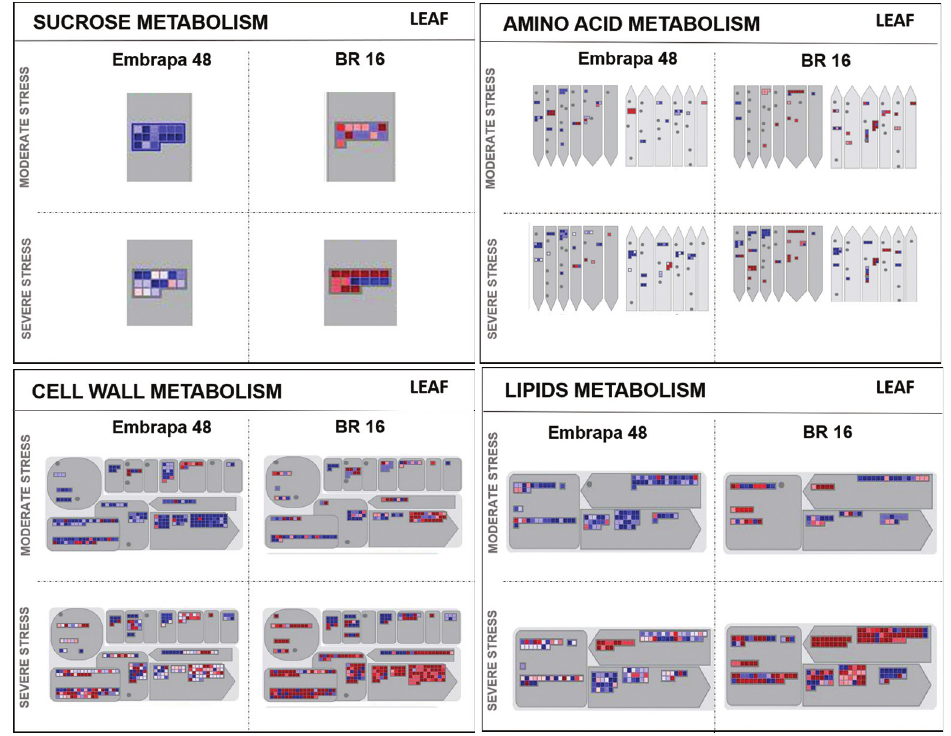
Figure 5 - Metabolism overview mapping (MapMan 3.6 ORC). Genes that were differentially expressed in response to water deficit were mapped to spe- cific stress-related gene groups (sucrose, amino acid, cell wall and lipid metabolism) for leaf from Embrapa 48 and BR 16 under moderate and severe stress. The color scale shows the log2 fold-change: red = down-regulated and blue =